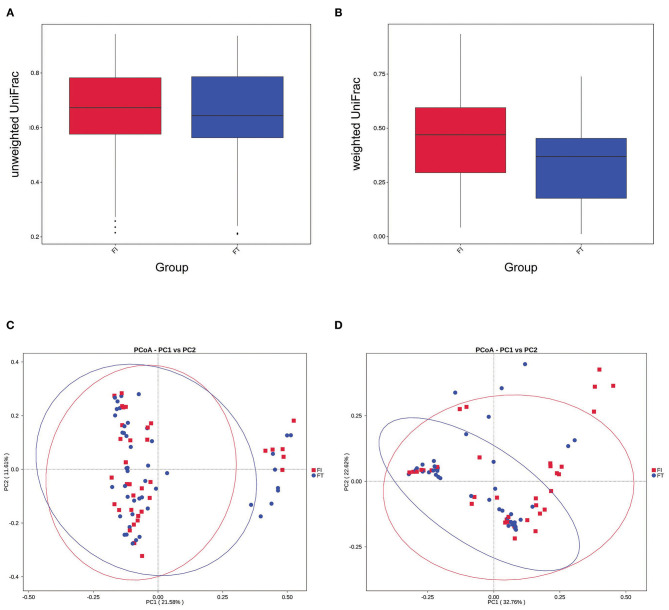
β- diversity analysis. (A) Box diagram based on unweighted UniFrac beta diversity P = 0.055 (t-test) and P = 0.040 (two-wilcox). (B) Box diagram based on weighted UniFrac beta diversity P < 0.001. (C) PCoA analysis based on unweighted UniFrac distance. (D) PCoA analysis based on weighted UniFrac distance.